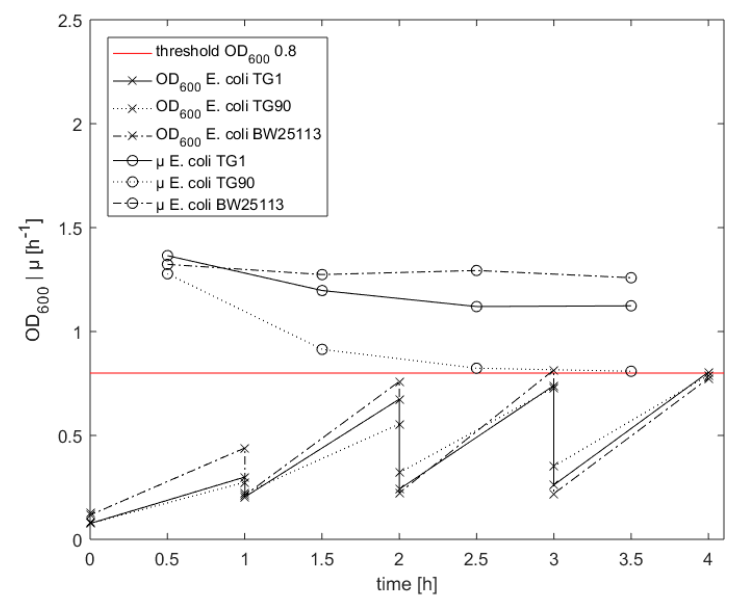
Figure 6. Quasi-turbidostat approach for harvesting of competent cells in a defined physiological state. Biomass is measured every hour. Depending on µ and biomass a dilution of the culture is performed.